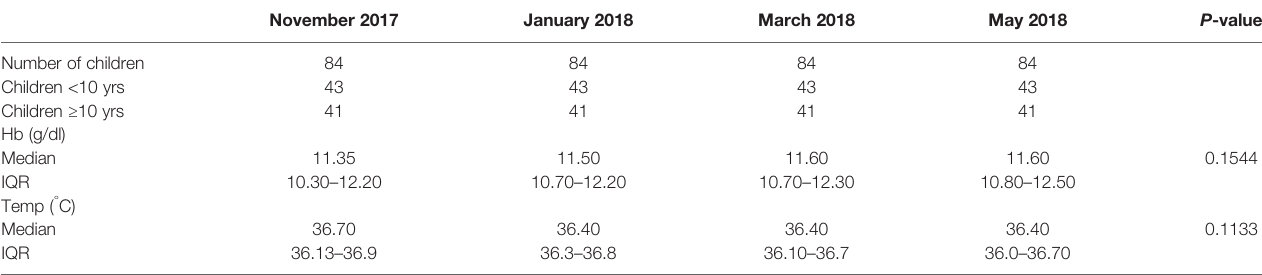
TABLE 1 | Characteristic of the study participants.